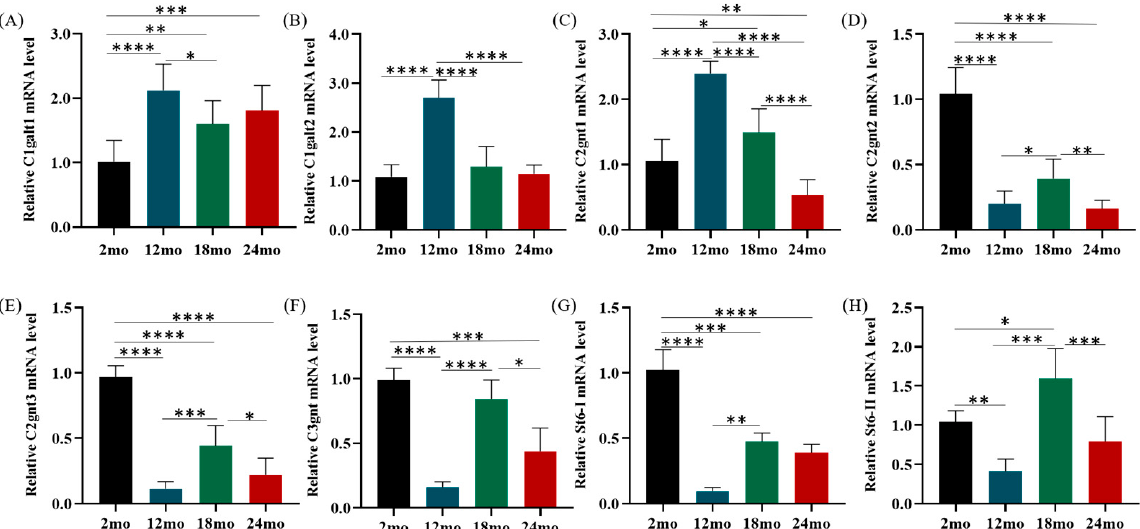
Figure 6. Altered mRNA expression of glycosylated transferase during aging. mRNA level of key enzymes in core 1 ( A , B ), core 2 ( C – E ), and core3 ( F ) formation in colon. Gene expression of the mucin-type O-glycan modifying enzymes ( G , H ) in colon tissue were measured. Data were presented as mean ± SD. Data were statistically analyzed using one-way ANOVA with Tukey’s post hoc test. Asterisk indicates significant difference, * p < 0.05, ** p < 0.01, *** p < 0.001, **** p < 0.0001, n = 3 per group.